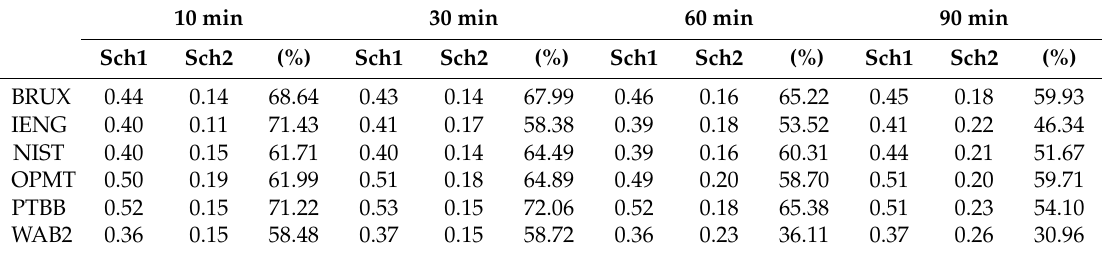
Table 4. RMS of the clock difference between the solutions obtained with two different schemes with respect to the solutions obtained with the complete data when data interruption occurs (ns).